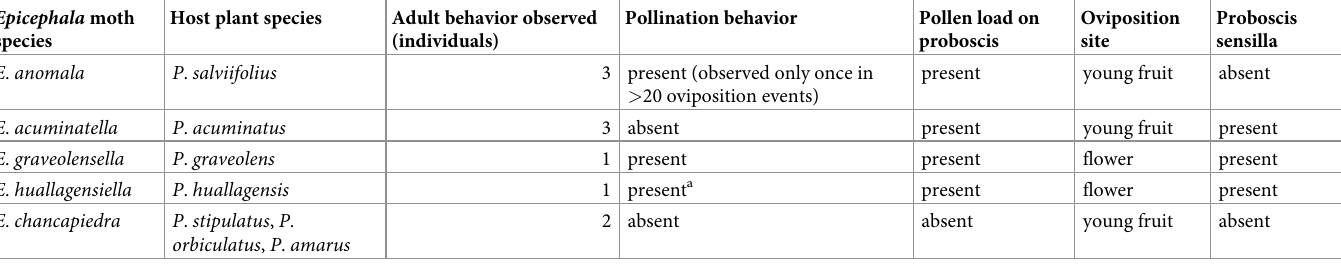
Table 1. Host plant species and pollinator habit of the five Epicephala species described in this